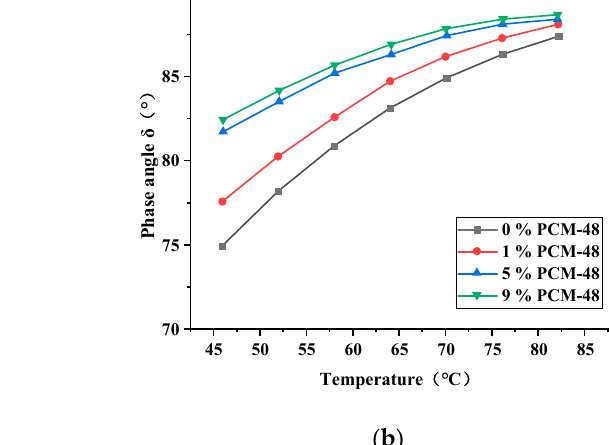
Figure 5. The complex modulus of asphalt with different dosages of PCM: ( a ) PCM-43; ( b ) PCM-48. With the increase of the temperature, the phase angles of the asphalt with different dosages of PCM gradually increase (Figure 6). This illustrates that the viscous part of the asphalt increases and the elastic part decreases after the temperature increases such that the phase angle of asphalt becomes larger [19]. The phase angles of two asphalts with PCM are larger than that of the base asphalt at any temperature. At the same dosage, the influence of PCM-48 on asphalt is slightly greater than PCM-43.